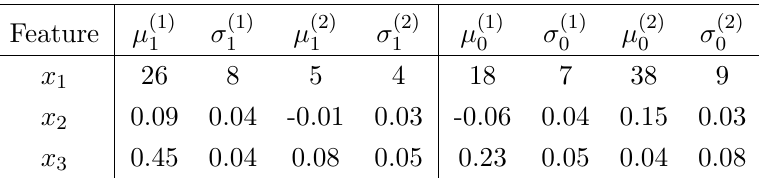
Table 2 . Mean and standard deviations of the normal distributions used for the classes 0 and 1. Each feature (variable) is derived from the bimodal distribution in eq. (3.1) with the events spread evenly between distributions j = 1 ; 2.